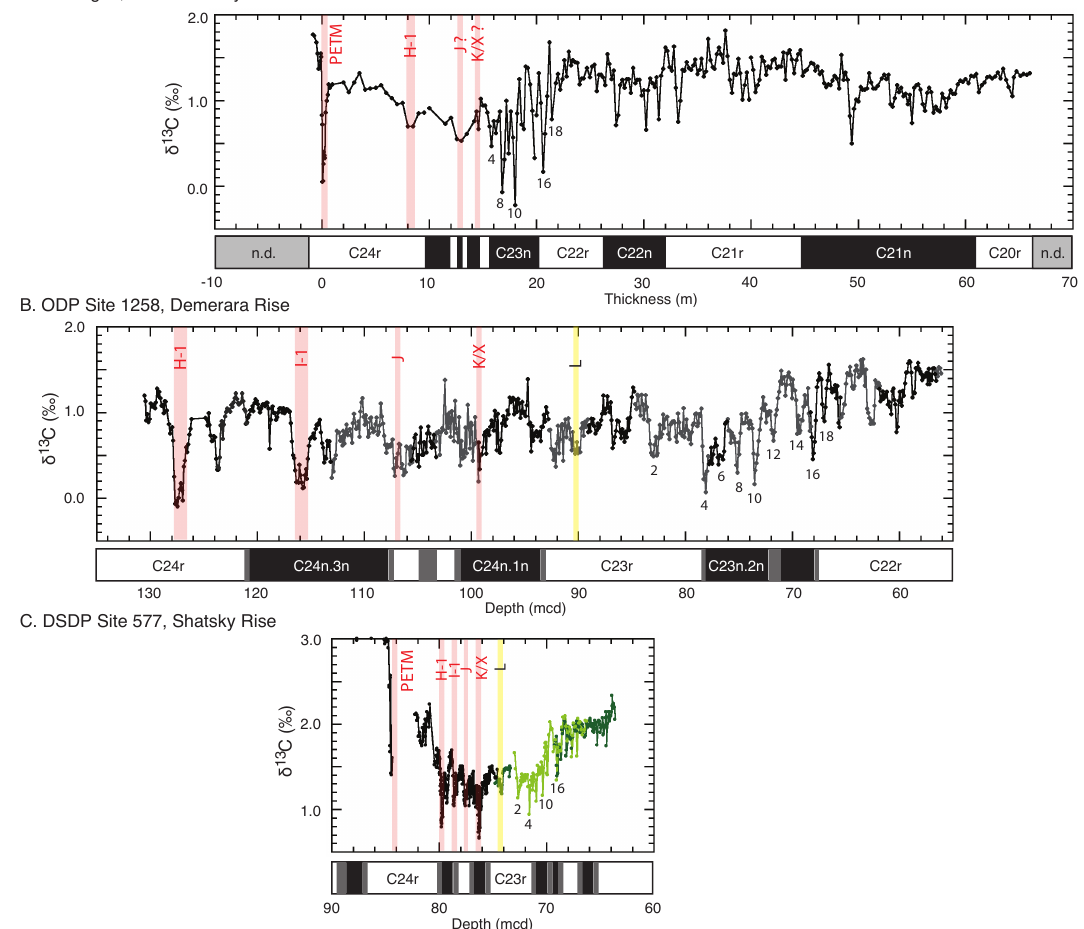
Figure 9. Carbon isotope and paleomagnetic records across the early Eocene for the Possagno section, DSDP Site 577 and ODP Site 1258 (Kirtland-Turner et al., 2014). This highlights the overall framework of carbon cycling in the early Eocene but also stratigraphic problems across the EECO at each of the three sites. At Possagno, the coarse resolution of δ 13 C records and the condensed interval make correlations difficult. At ODP Site 1258 the prominent K/X event seems missing. At DSDP Site 577, the entire record is compressed in the depth domain. Nonetheless, a major shift in frequency and amplitude of carbon isotope excursions (CIEs) appears to have happened during the EECO. CIEs that may correlate within the EECO are shown with